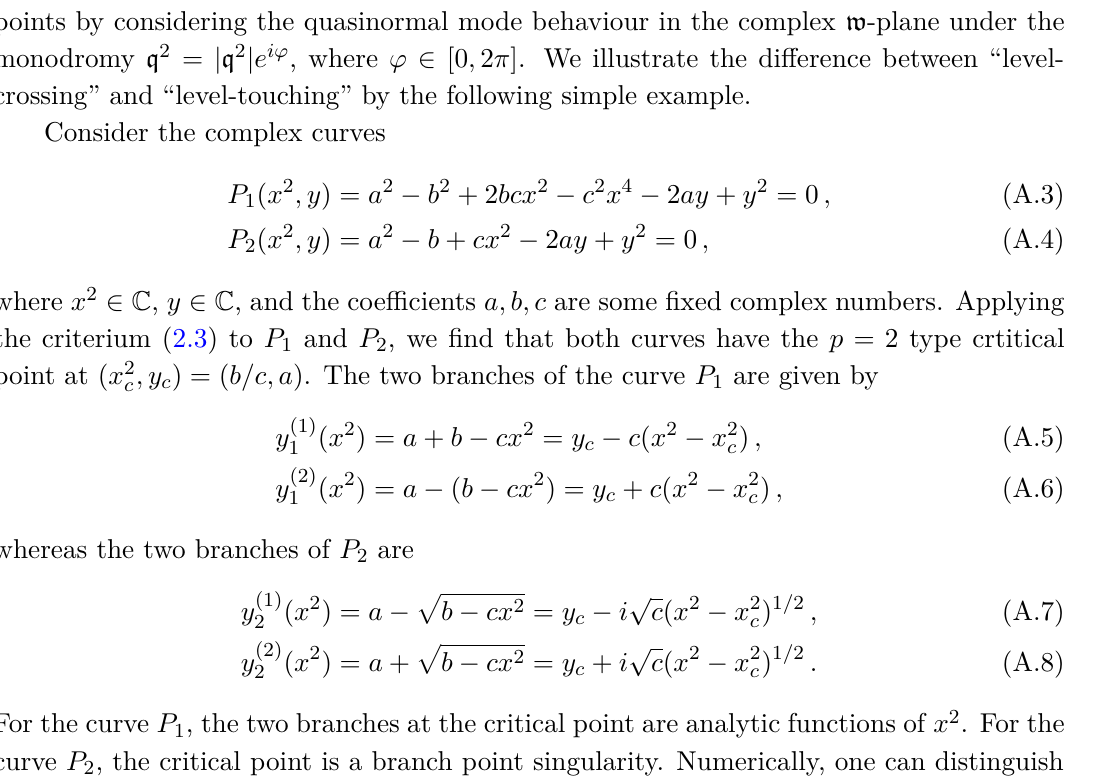
in the complex q 2 -plane, and then determines the degree of the singularity at the critical points by considering the quasinormal mode behaviour in the complex w -plane under the monodromy q 2 = | q 2 | e iϕ , where ϕ ∈ [0 , 2 π ] . We illustrate the difference between